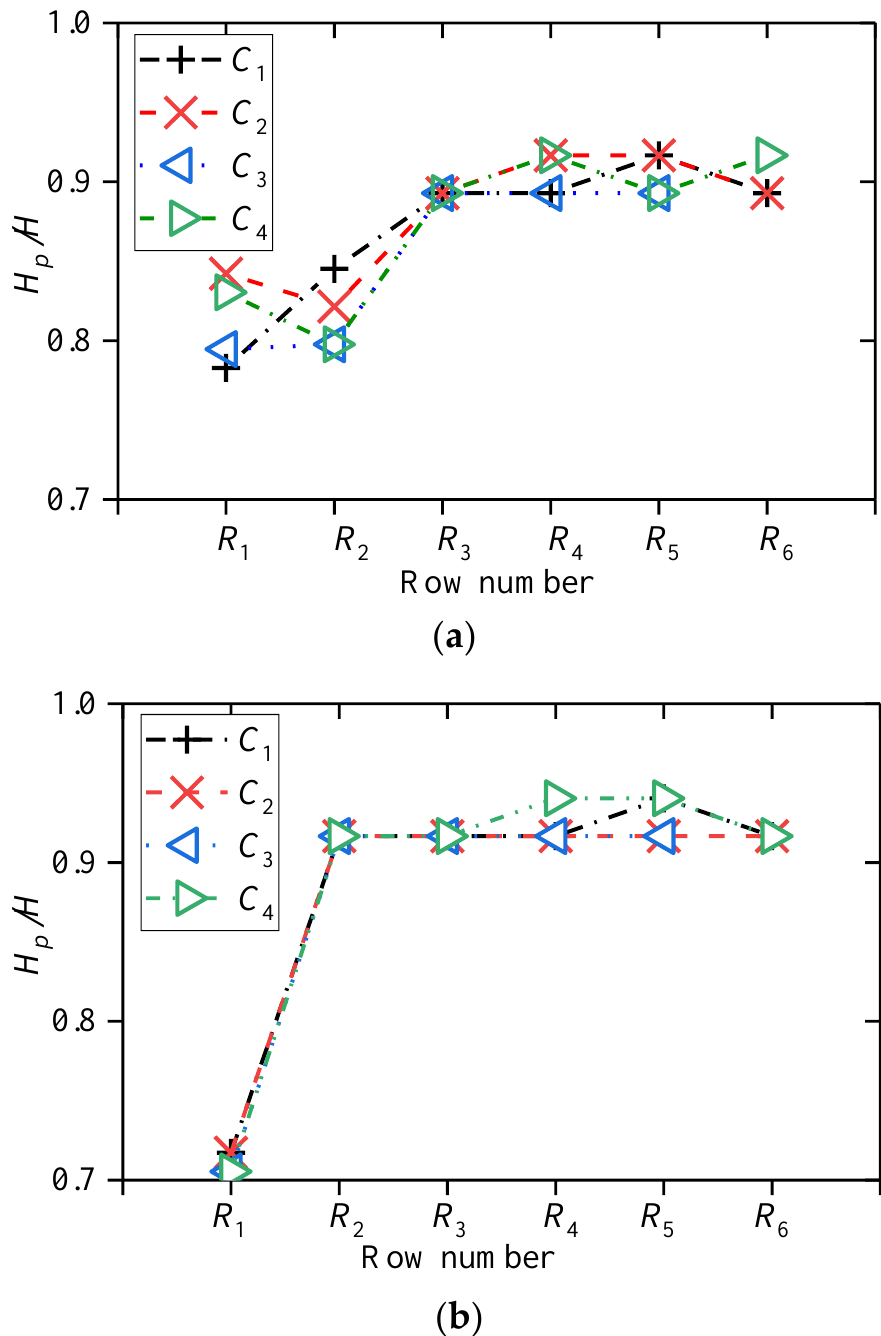
Figure 22. Heights corresponding to the peak sectional drag coefficients H p normalized by the building height H for ( a ) DWP and ( b ) SWP.